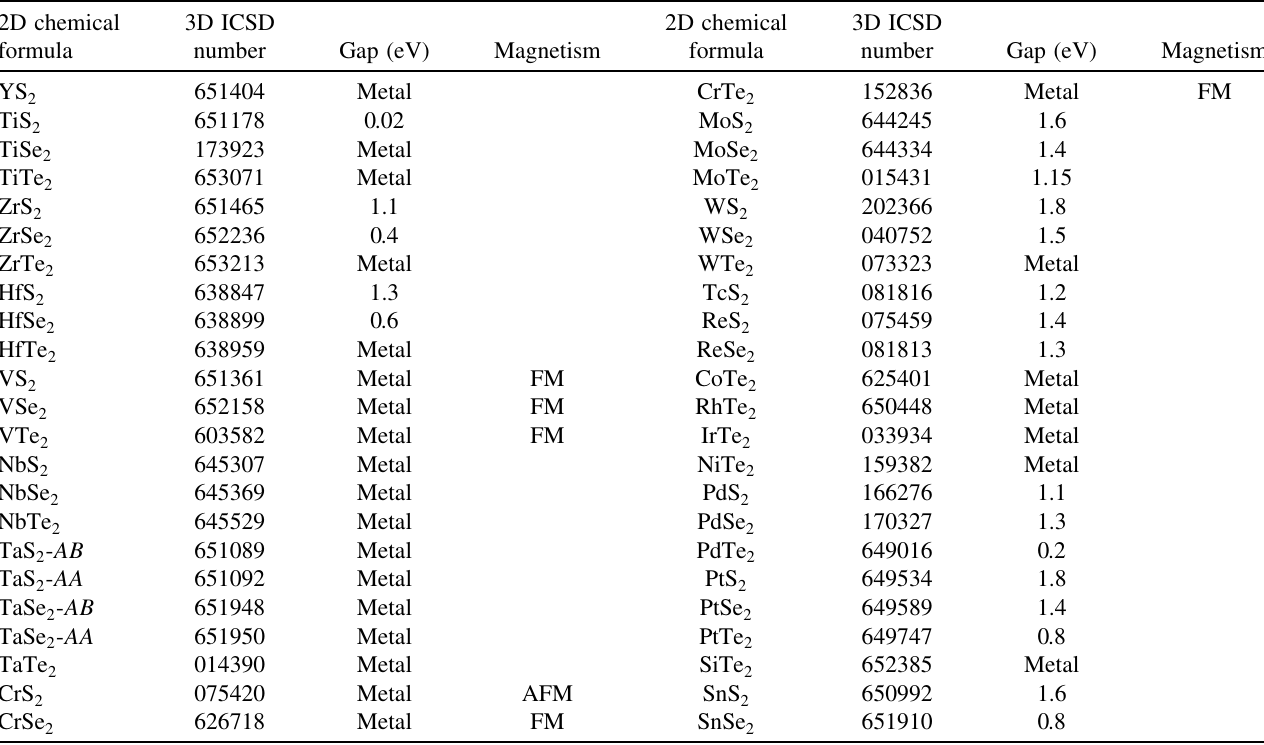
TABLE II. List of two-dimensional dichalcogenides found by our search algorithm with the ICSD number of the corresponding bulk material and with our calculated band gap (in eV). The corresponding magnetic state (AFM refers to an antiferromagnetic ordering) is given in the last column to the right. (The cells of the table are left blank if the material is not magnetically ordered.) 2D chemical